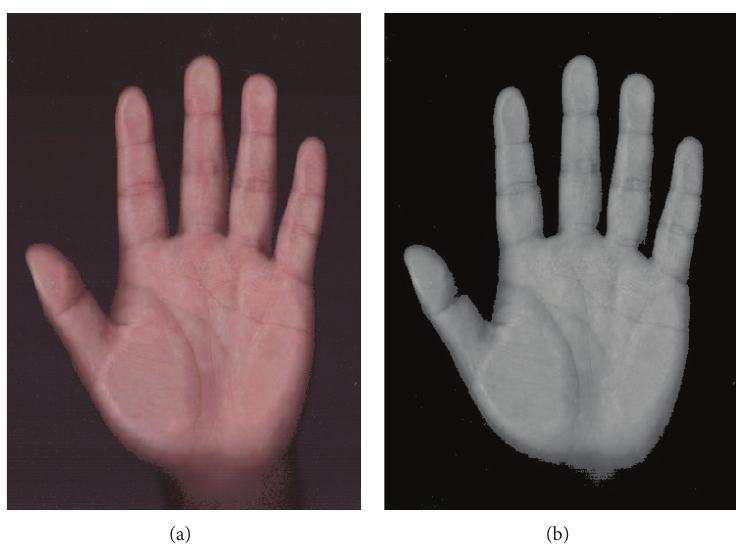
Figure 7: (a) The original image and (b) the filter image of